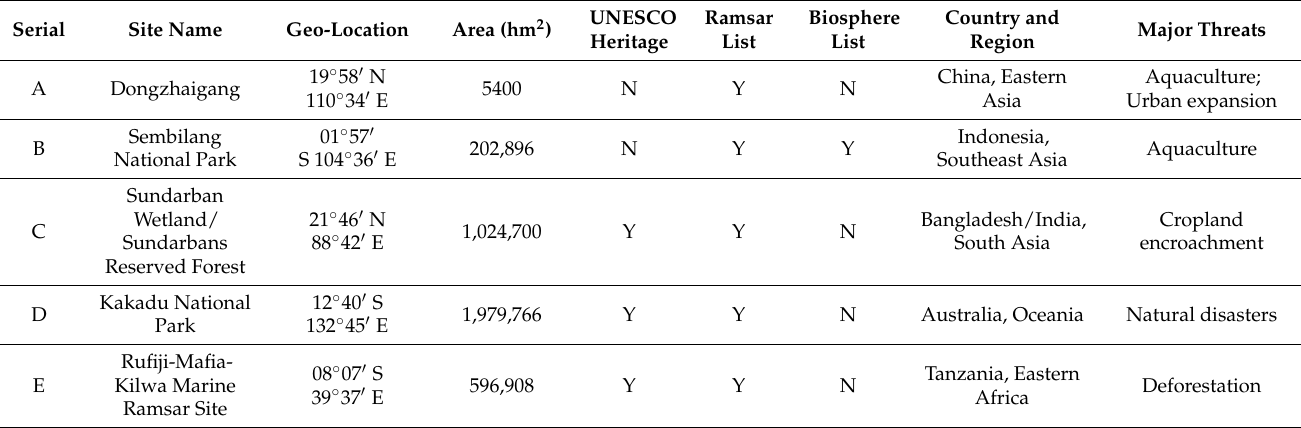
Table 1. The check list of five study sites to be finally